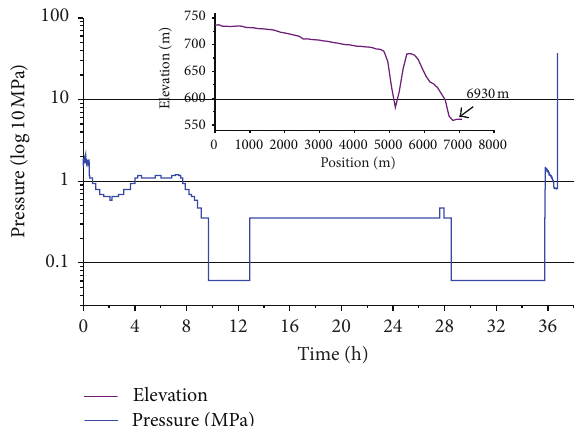
Figure 5: Numerical result of pressure at the end of pipe for the first accident.